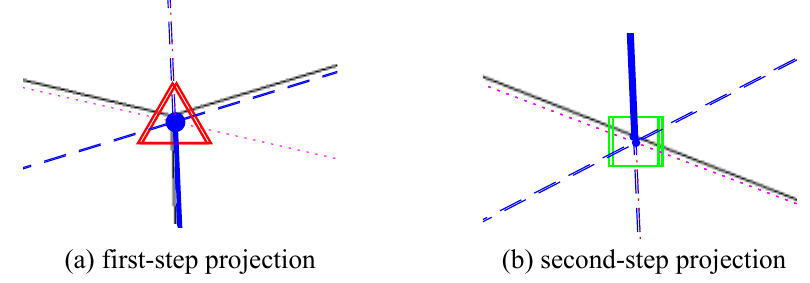
Figure 5. Demonstration of projection error during the base point searching process, ( a ) triangles are the first projection points on the Y–Z plane; ( b ) squares are the second projection points on the Y